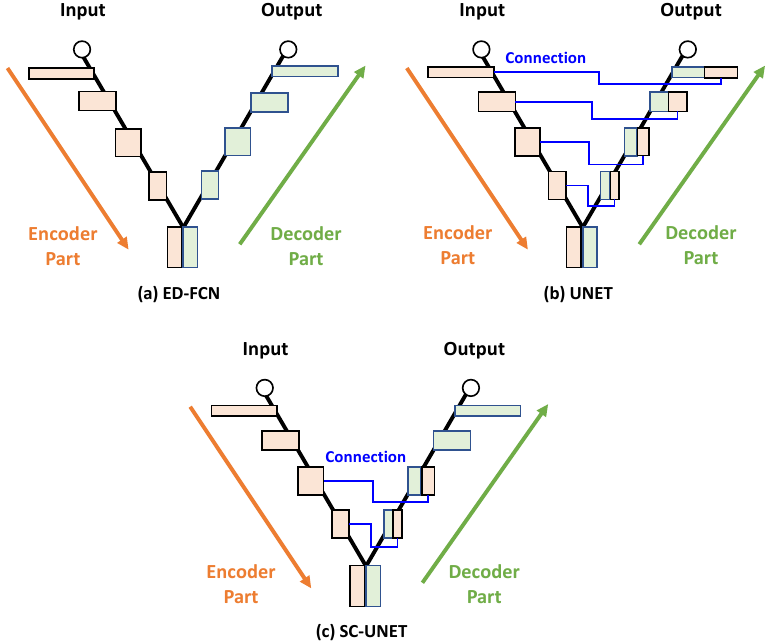
Figure 1. Various network architectures for semantic